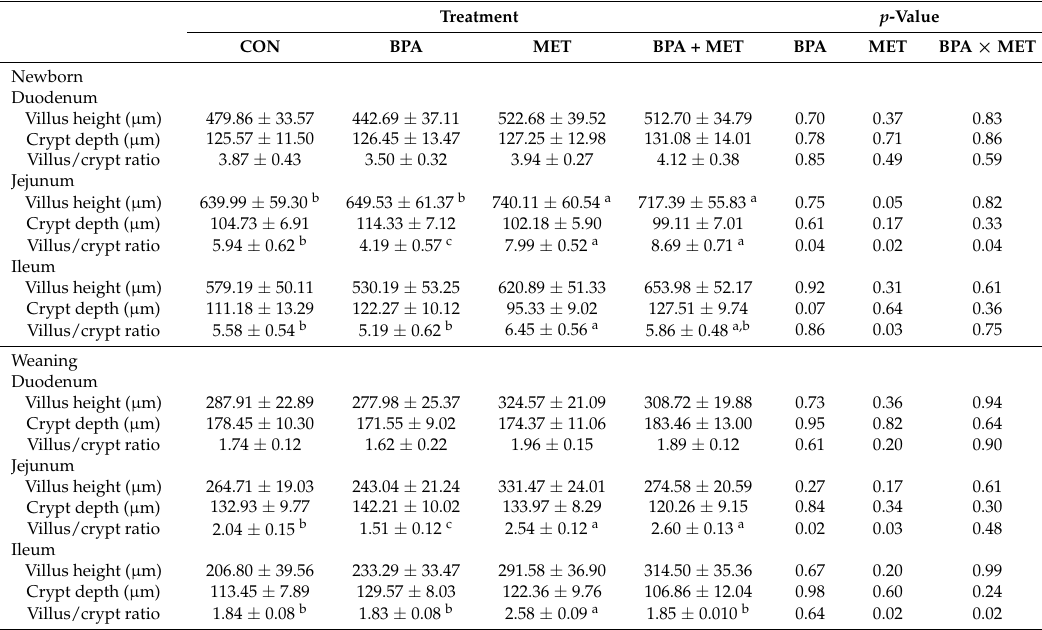
Table 5. Effect of maternal methyl donor or bisphenol A supplementation during gestation on intestinal morphology in newborn and weaning